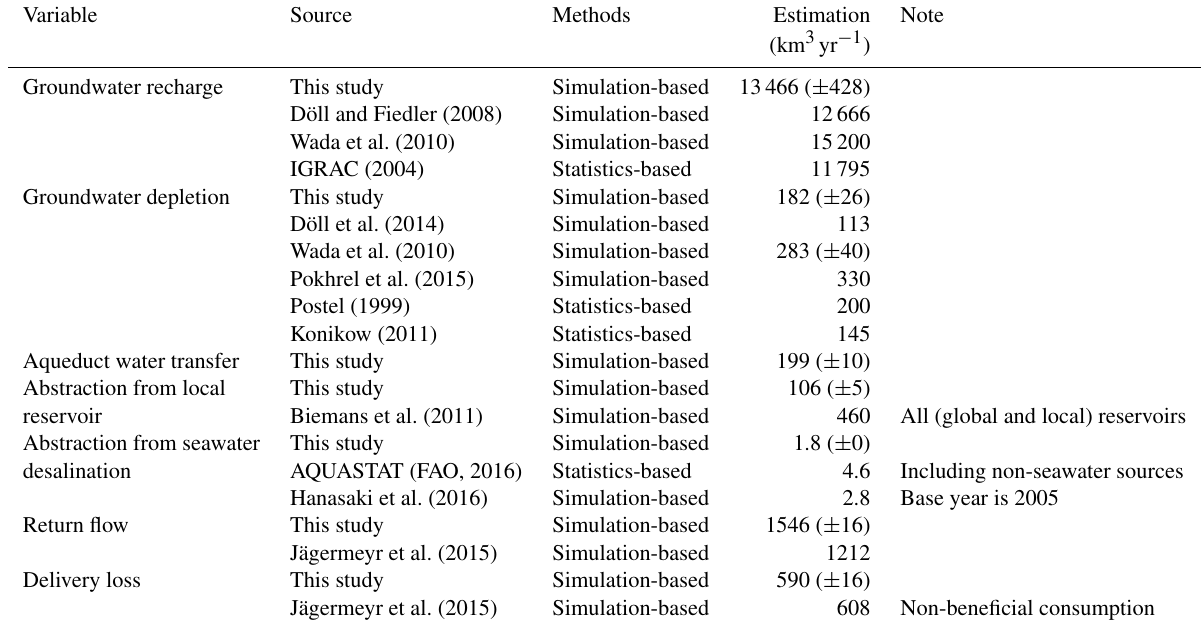
Table 2. Global mean annual fluxes derived from the new model components and comparison with previous estimates. The range shows ± 1 σ of inter-annual